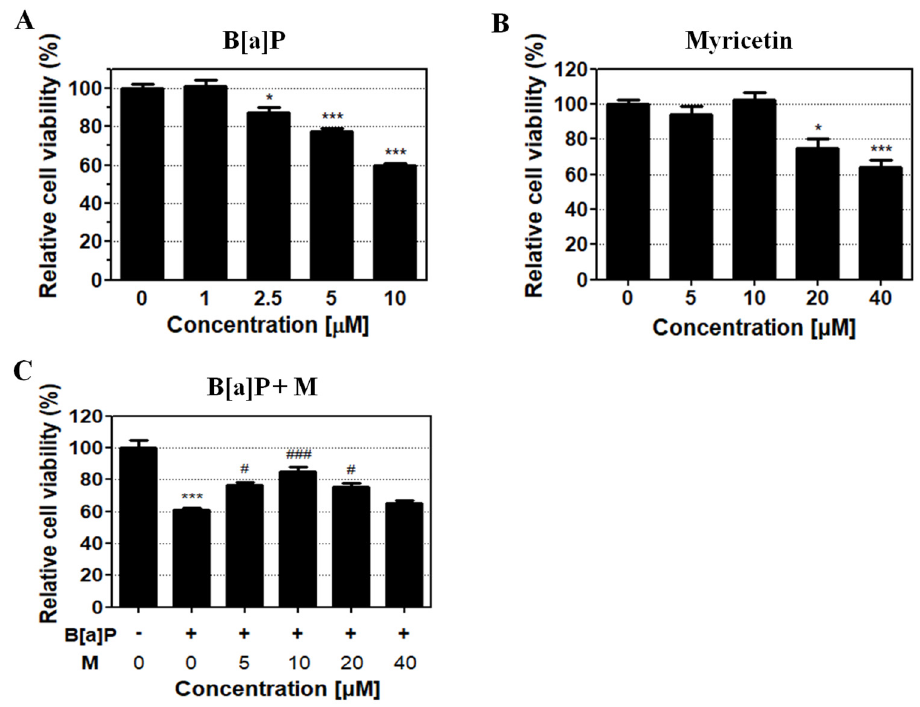
Figure 2. B[a]P and myricetin cytotoxicity in HepG2 cells. ( A , B ) HepG2 cells were treated with B[a]P (0, 1, 2.5, 5, and 10 μ M) or myricetin (0, 5, 10, 20, and 40 μ M) at different concentrations for 48 h. ( C ) The protective effect of myricetin against B[a]P-induced cytotoxicity was measured with B[a]P (10 μ M) co-treatment with various concentrations of myricetin for 48 h. All treatment group values are significantly di ff erent when compared with controls (* p < 0.05, *** p < 0.001) and B[a]P (# p < 0.05, ### p < 0.001). Tukey’s multiple comparison test. M: